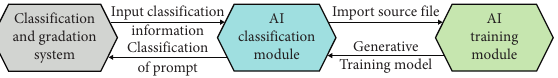
Figure 3: AI intelligent classification module